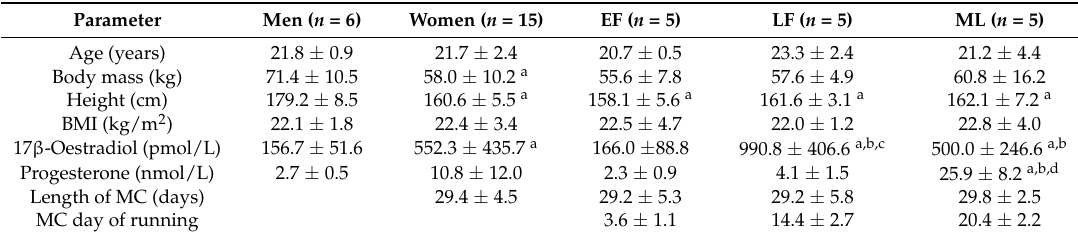
Table 1. Participant